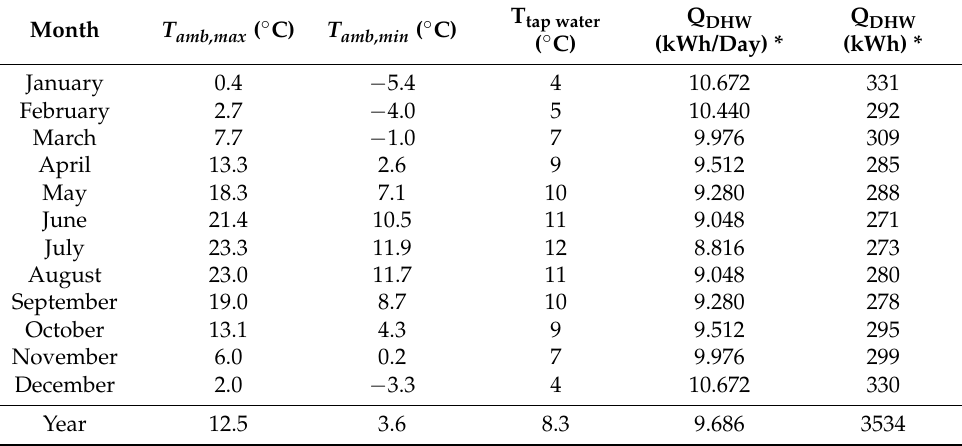
Table 1. Household expected DHW day and month energy demands, according to historical average maximum/minimum ambient and tap water temperatures.